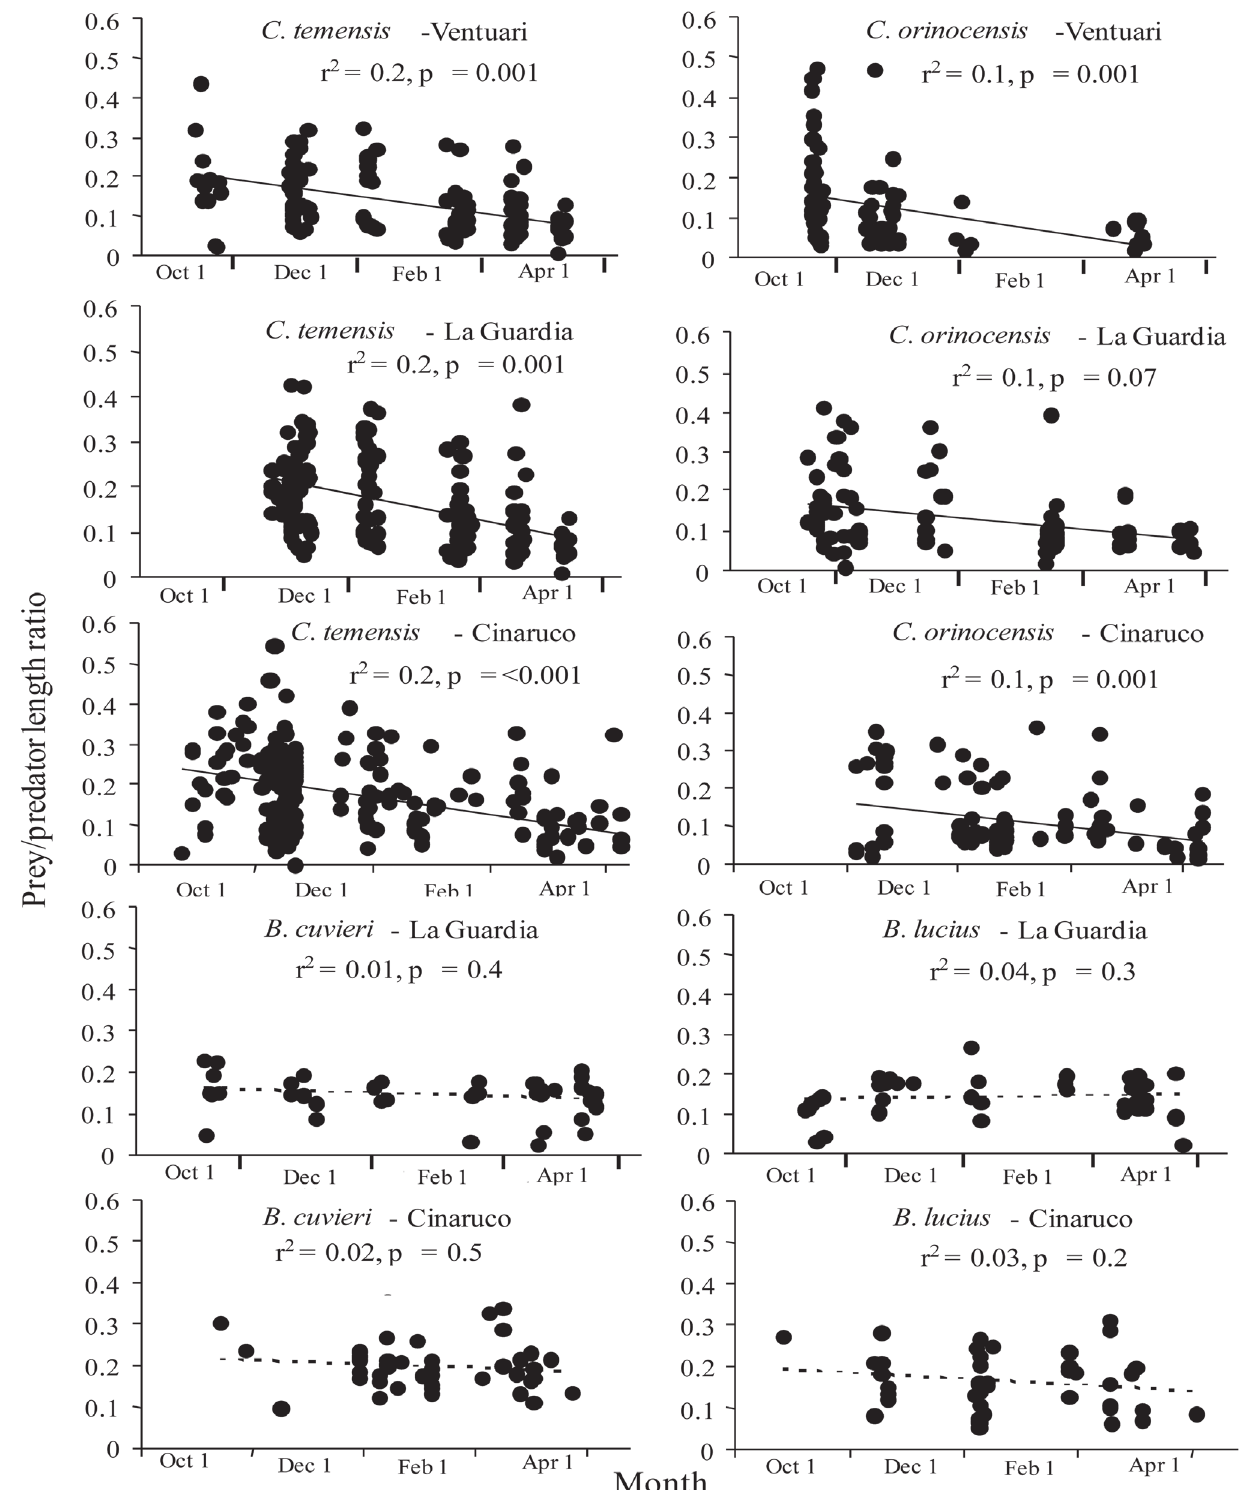
Fig. 5 . Prey/predator body length ratios for four predator species. Relationships are presented from falling water (October) to rising water (May) period. Significant relationships are represented by a solid line and non-significant relationships with dotted lines. Number of stomach contents examined during the study period: Ventuari: C . temensis = 408, C . orinocensis = 698; Cinaruco: C . temensis = 1365, C . orinocensis = 755, B. cuvieri = 292, B. lucius = 411; La Guardia: C . temensis = 444, C. orinocensis = 228, B. cuvieri = 93, B. lucius =